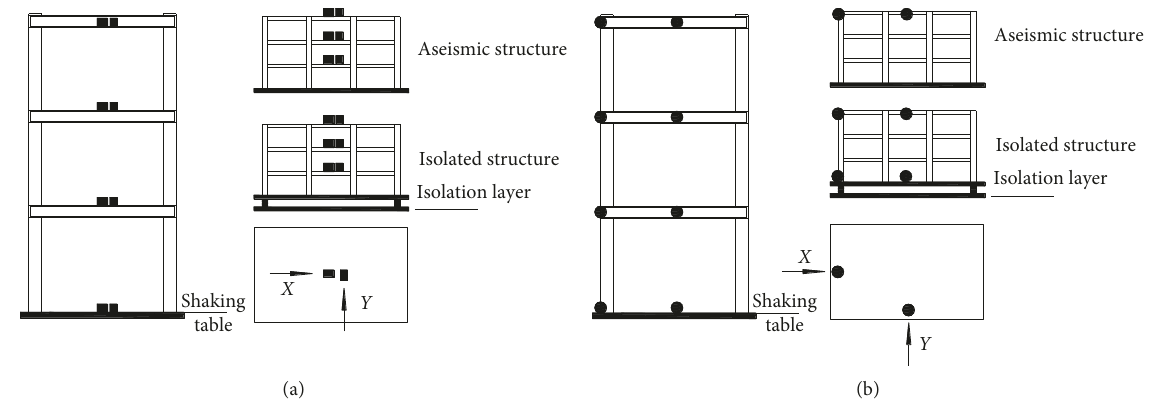
Figure 2: Sensor layout: (a) acceleration sensor; (b) displacement